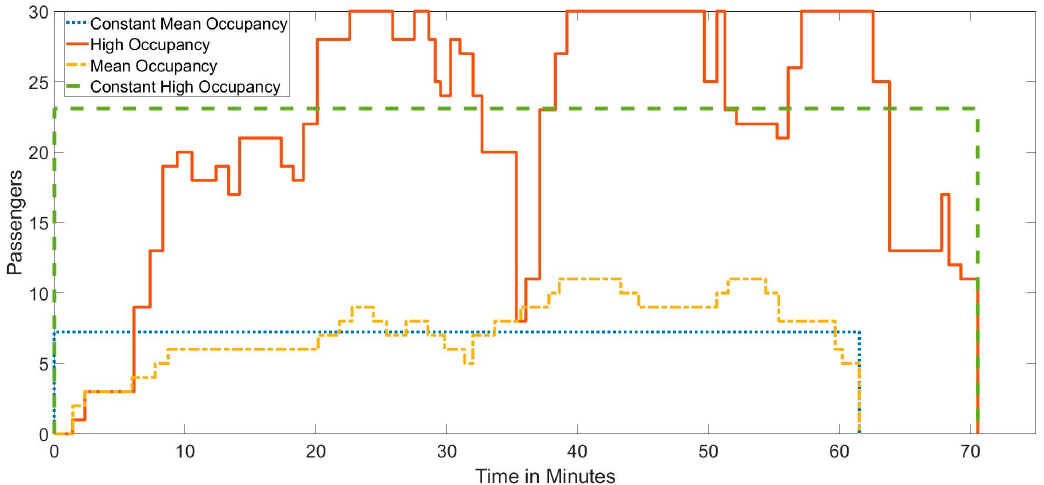
Figure 5 . Mean and high passenger occupancy profiles with/without passenger variation .